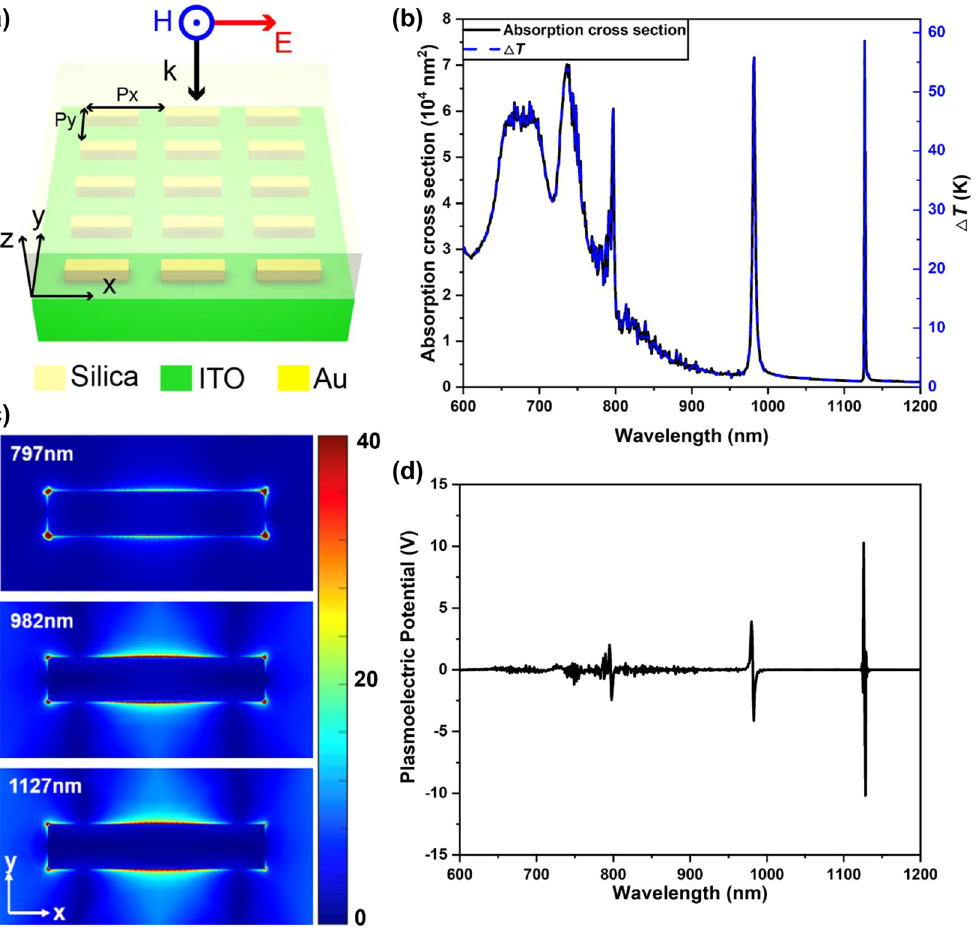
Figure 6: Temperature rise and PEP induced by plasmonic lattice mode. (a)Schematicofanarrayof415nm × 85nm × 38nmgoldcutwiresloadedonanITOsubstrateandcoveredbyasilicasuperstrate.Thearrayhasa period of 600 nm in the x -direction and 300 nm in the y -direction. (b) Simulated absorption cross-section spectrum (left axis) and calculated correspondingtemperaturerise(rightaxis)forthesystemin(a).(c)Simulatedelectricnear- fi eldintensitydistributionsatthethreelatticemodes located at 797 nm, 982 nm, and 1127 nm in the long wavelength range of (b). (d) Calculated PEP spectrum of the system with a rapid calculation method under the fi nite charge transfer approximation under an illumination spot of 0.2 cm diameter and uniform intensity of 200 W/cm 2